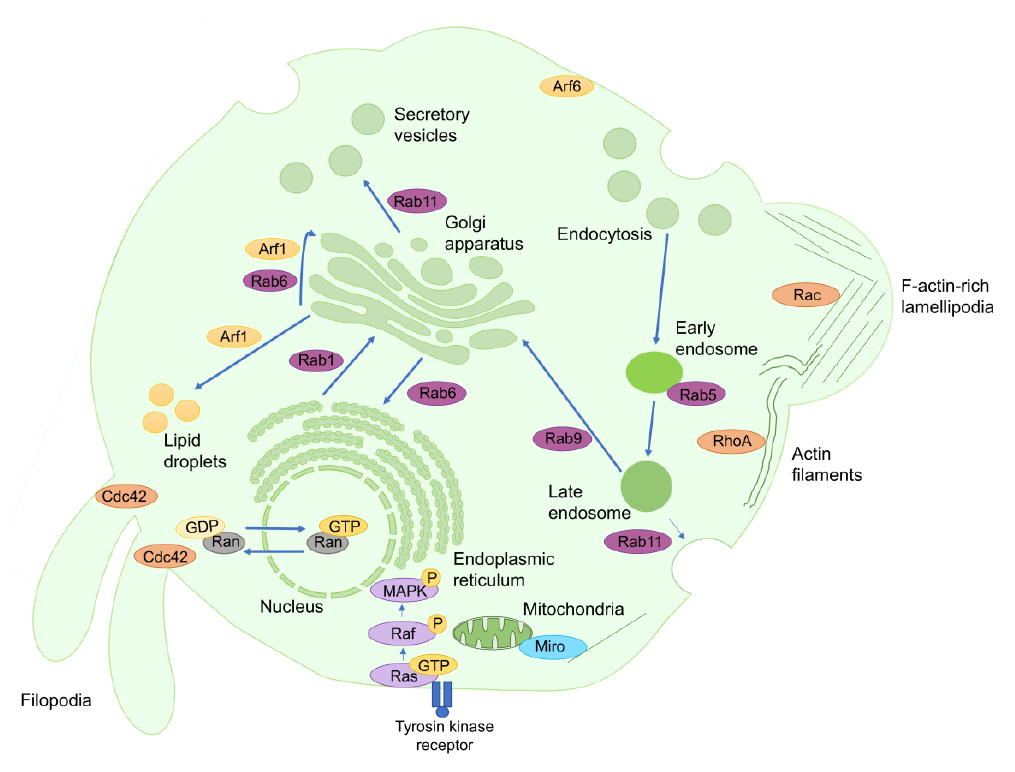
Figure 1. Role of small GTPases in human cells. Most small GTPases are implied in the regulation of protein secretion, endocytosis and vesicle trafficking. For instance, Ran-activation gradient